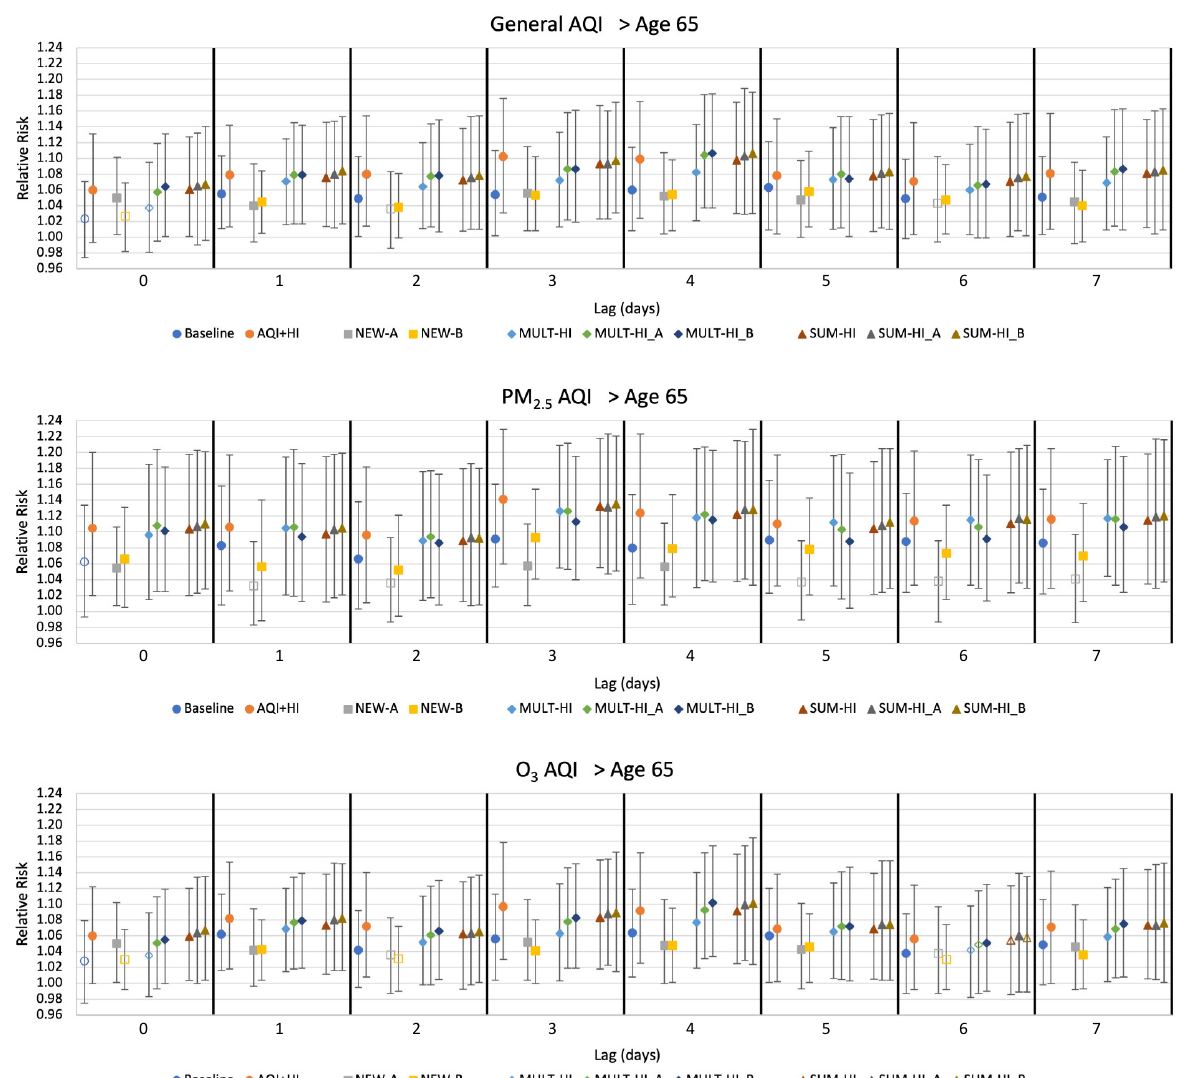
Figure 4. The interquartile relative risks and 95% confidence intervals for all models (deaths of persons >65 years). Model characteristics are described in Table 1. Solid symbols indicate significance at p = 0.05.